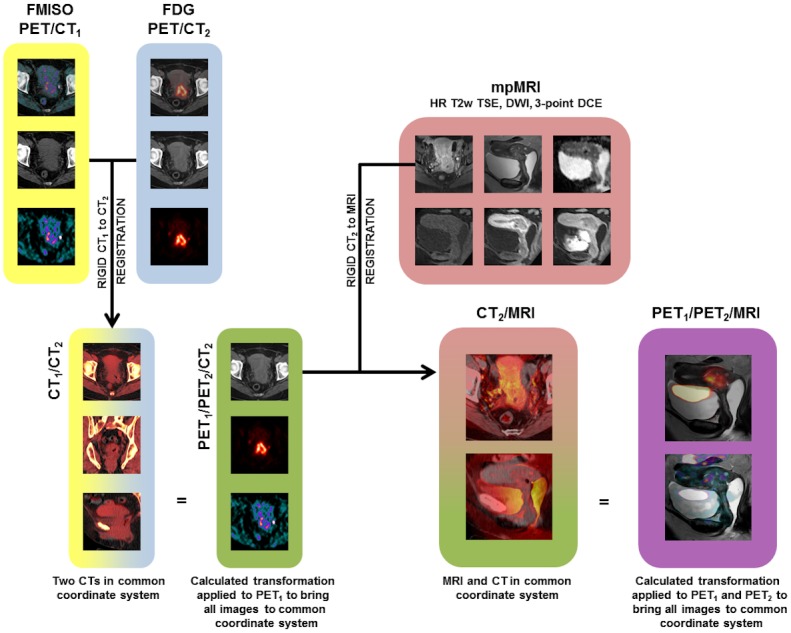
Step-by-step illustration of the rigid registration algorithm.[18F]FMISO and [18F]FDG/ PET/CT datasets in two separate coordinate systems (yellow and blue) are rigidly registered (CT1-CT2 registration) and merged into one (green). Registration between the green and the red (mpMRI) coordinate system is performed by a rigid transformation of CT2 to fit T1w MRI. The calculated transformation is applied to PET1 and PET2 to create the PET/MRI dataset (purple).